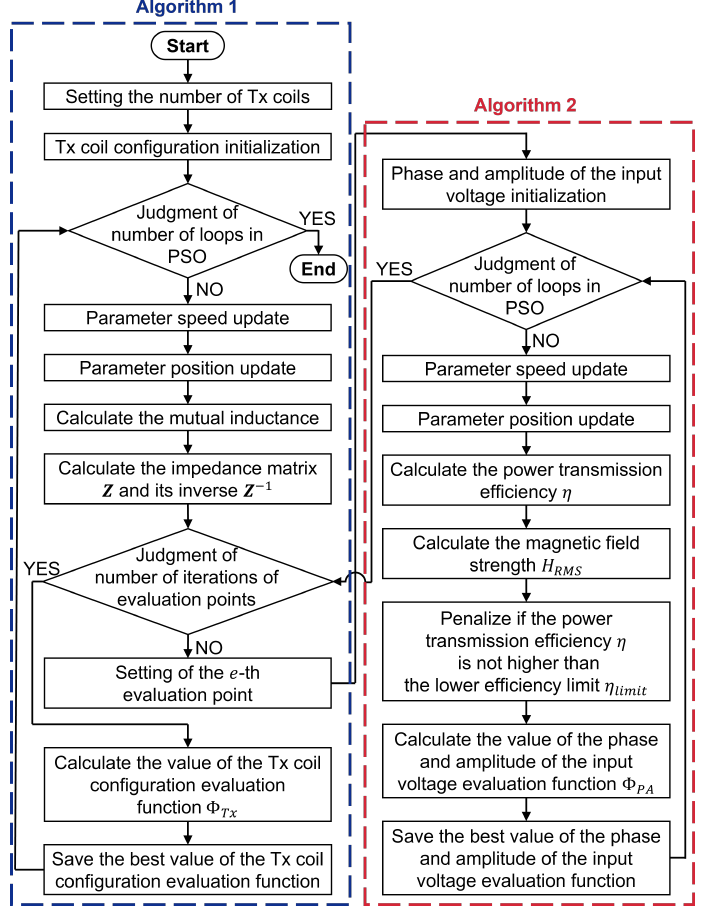
Figure 6. Flowchart of the optimization process using particle swarm optimization (PSO). This simu- lation program has a double-loop structure that consists of the optimization of the coil configuration and that of the phase and amplitude of the input voltage to each coil at each evaluation point in the evaluation